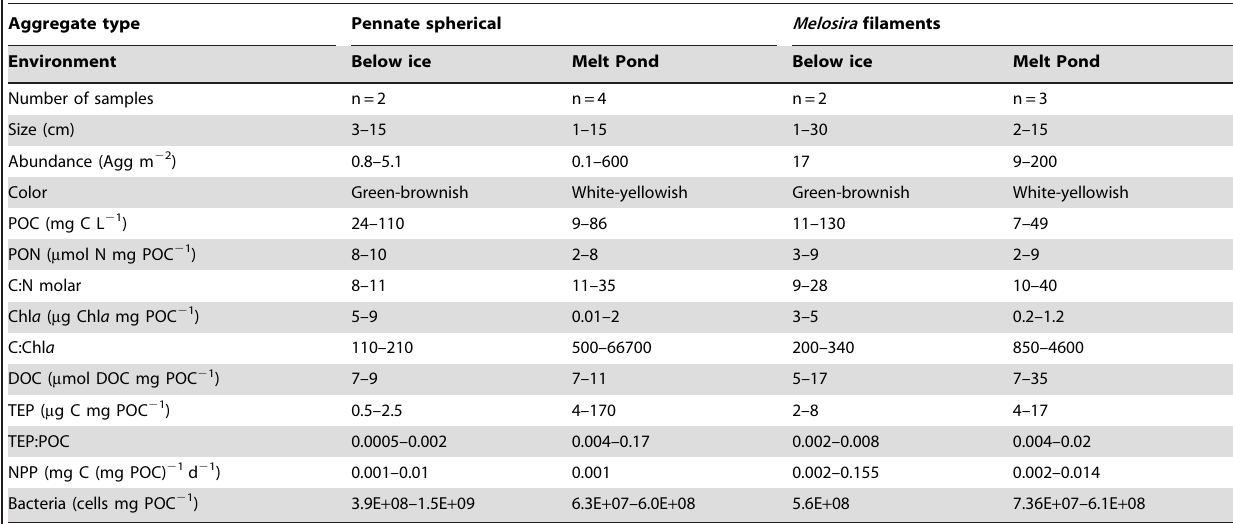
Table 1. Algal aggregate types and their degradation